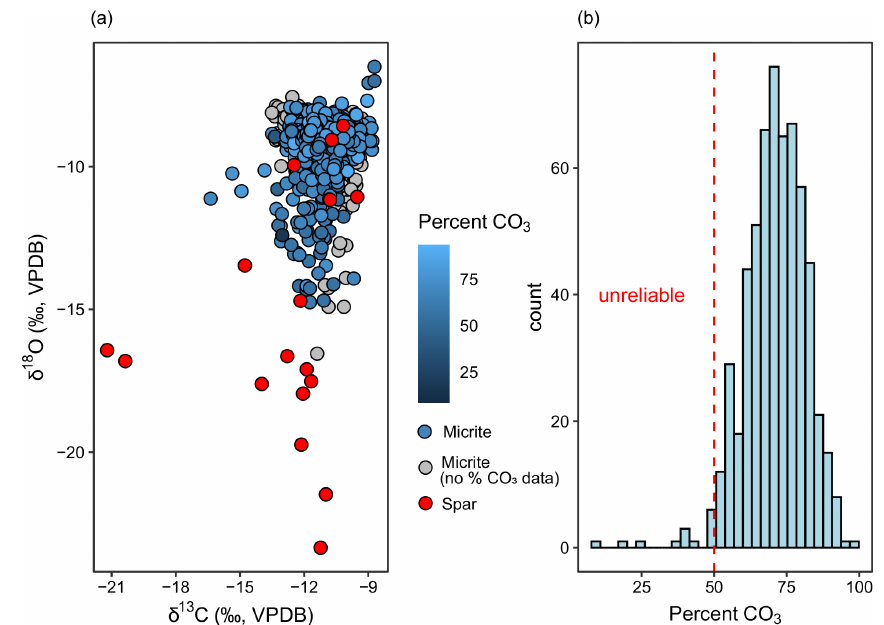
Figure 2. (a) The δ 13 C and δ 18 O for sparite and micrite samples measured from Fifteenmile Creek. Samples analyzed in the CUBES–SIL lab are colored according to their wt% CO 3 . Samples analyzed by the UMSIL lab are shown in grey. (b) Weight percent carbonate from the CUBES–SIL samples. A total of 12 samples with less than 50% CO 3 were considered unreliable and were